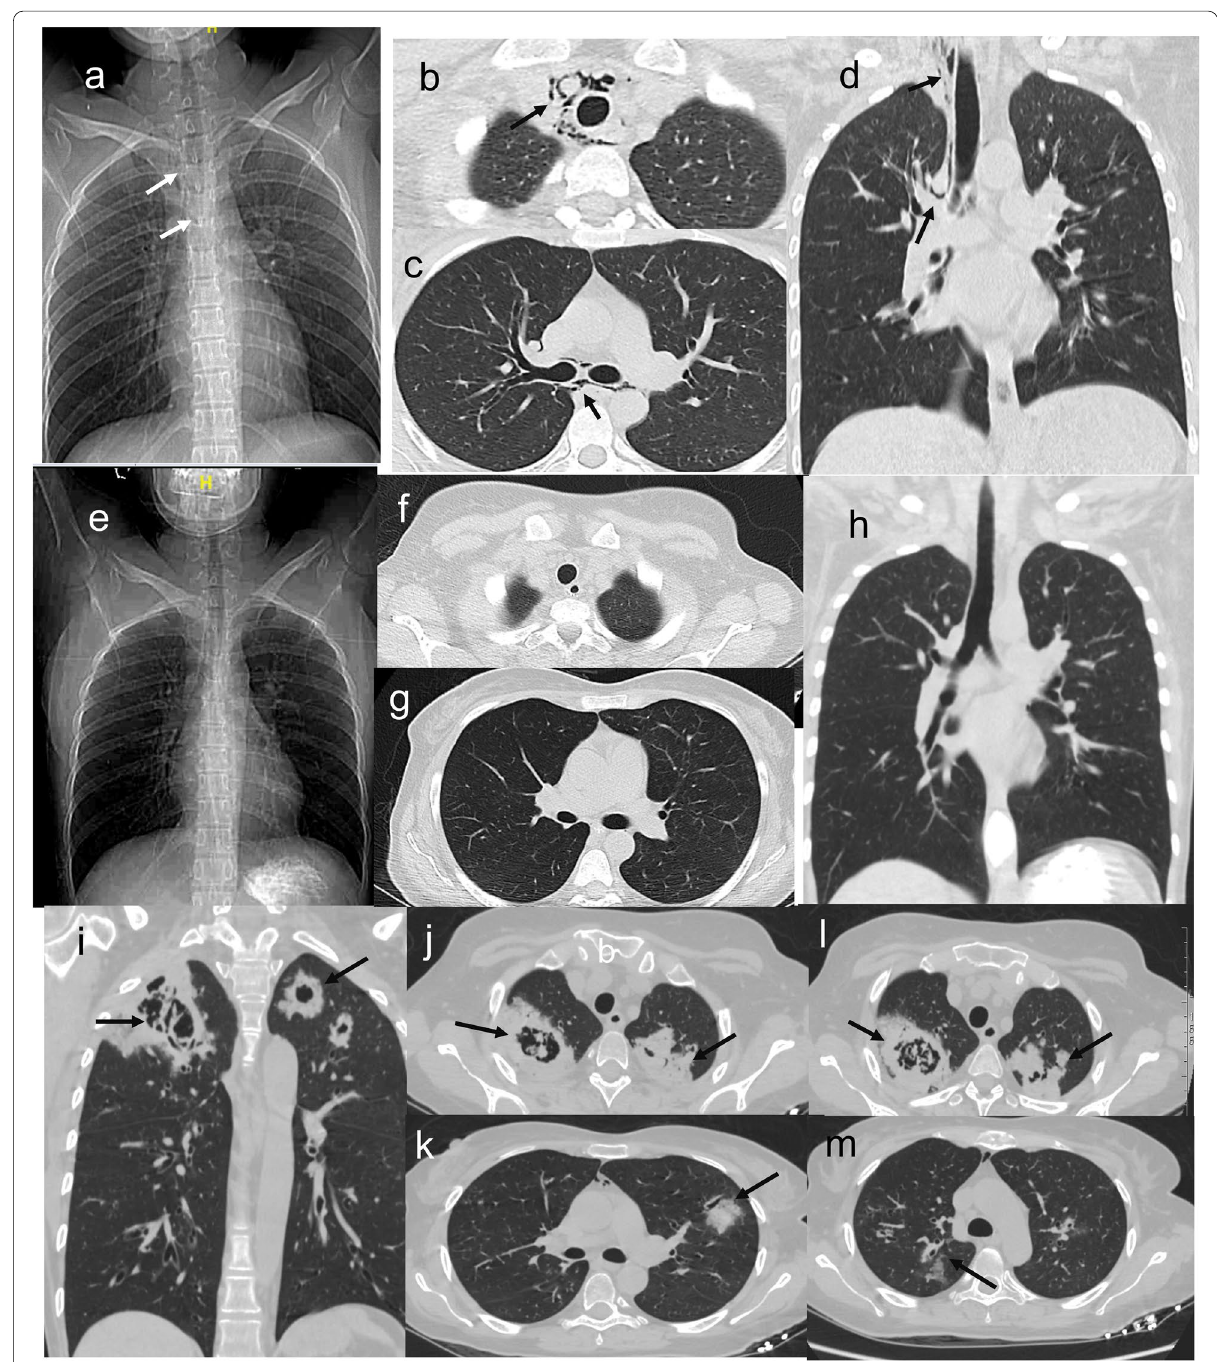
Fig. 1 a Chest radiograph shows air out lining the mediastinal contours. b , c Axial CT thorax section shows air outlining the mediastinal vessels and tracheobronchial tree. d Coronal CT thorax section showing pneumomediastinum. Repeat chest radiograph ( e ), repeat CT thorax, axial CT ( f and g ) and coronal CT ( h ) sections reveal resolution of pneumomediastinum. i – m CT taken during last admission demonstrates multiple thick-walled cavities with varying amounts of consolidations and nodules. A few of the cavities have nodular soft tissue densities and linear septa within them. CT, computed